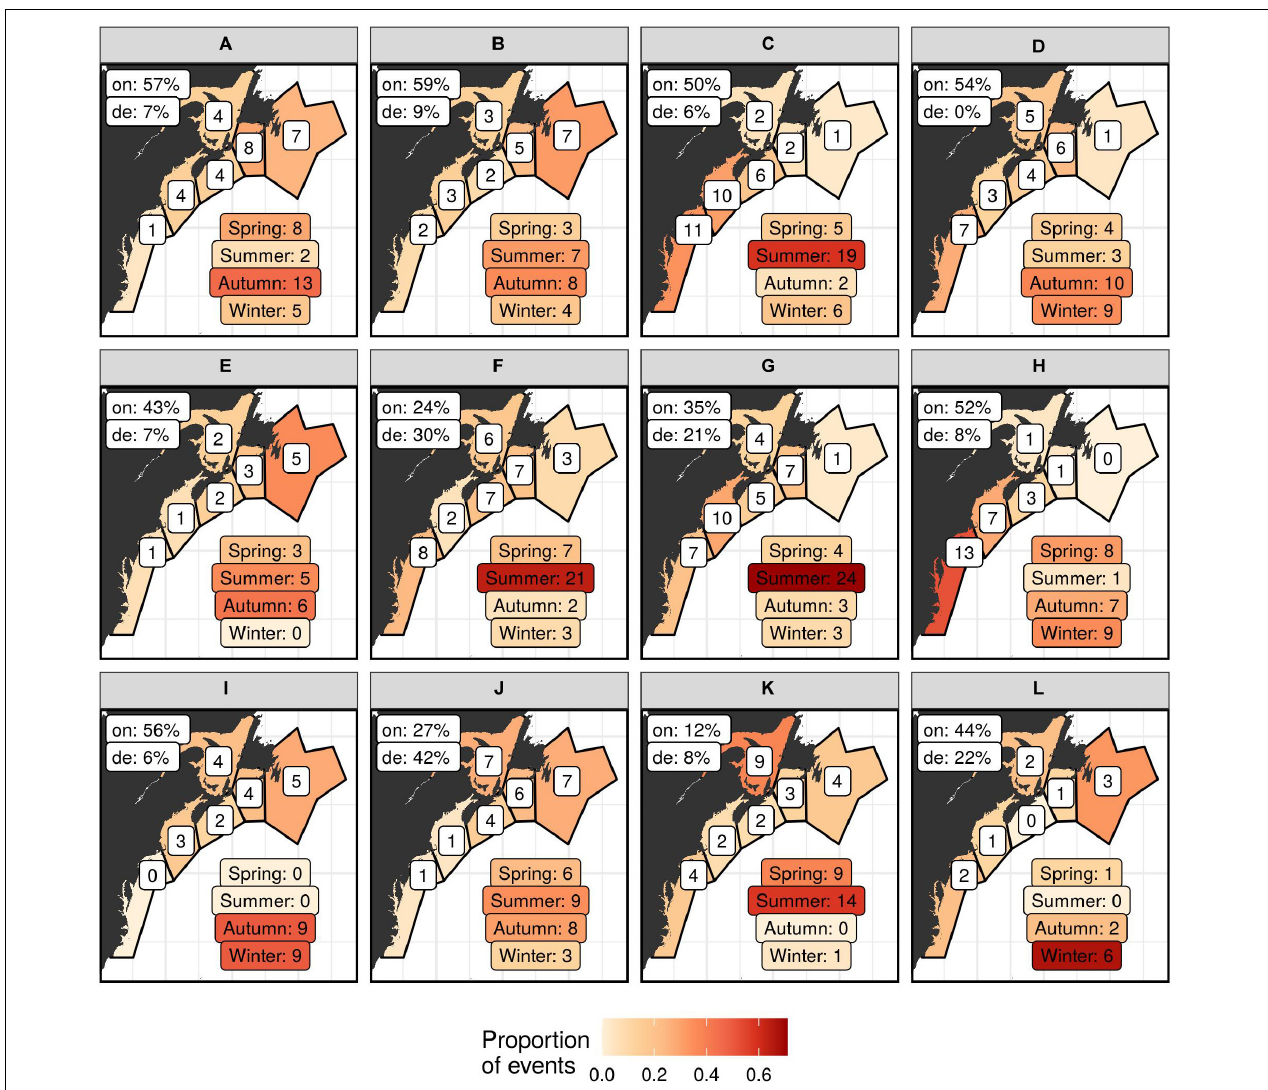
FIGURE 6 | The count of marine heatwave (MHW) occurrence across seasons and regions clustered into the 12 SOM nodes ( A–L ). The count of MHWs in each region are shown with white labels over the given region. The count of MHWs per season are shown in labels in the bottom right of each panel. The percentage of MHWs whose onset (on) or decline (de) was contributed to primarily by T Qnet are shown in the top left of each panel. Note that on average 49% of the onset of MHWs are driven by T Qnet and 17% of declines.